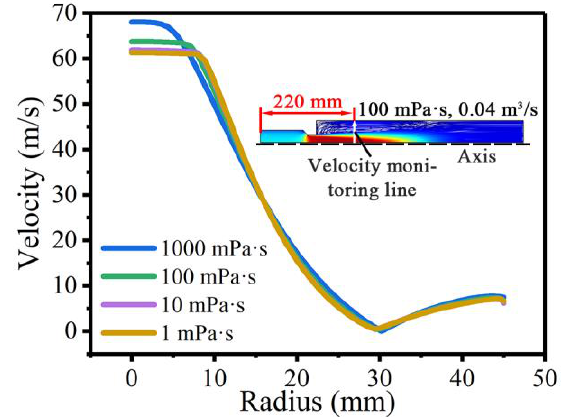
Figure 5. Velocity distributions at the monitoring line with different fluid viscosities; the flow rate was 0.04 m 3 /s.